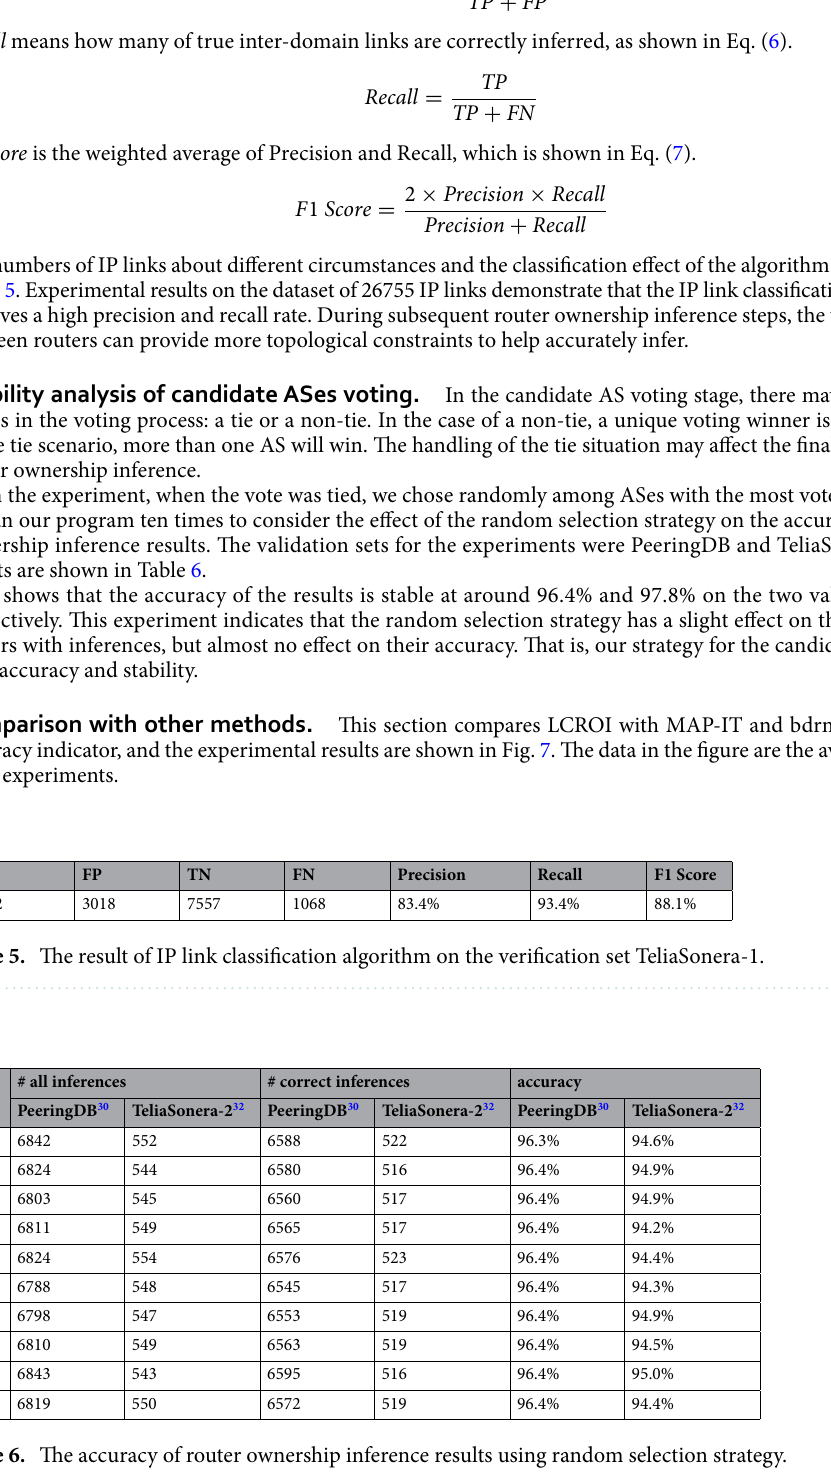
Table 6. The accuracy of router ownership inference results using random selection strategy.